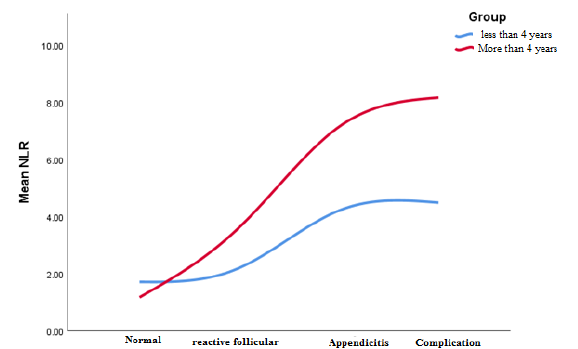
Figure 1 . Changes in the mean NLR in the four groups of less than 4 years and more than 4 years